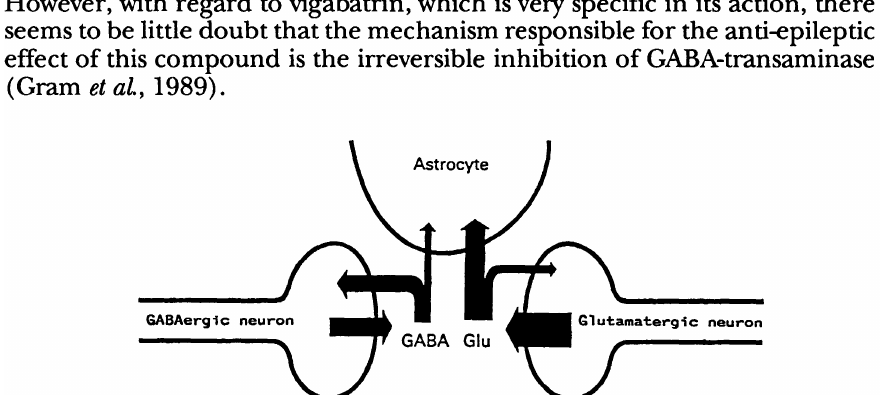
FIG. 1. Schematic diagram showing distribution of GAB A and glumate between neuron and astrocyte (glial